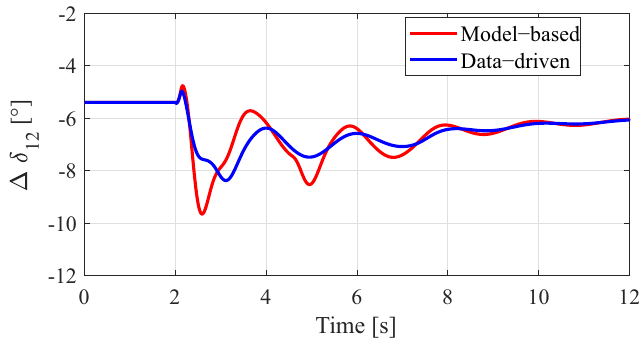
Figure 14. Rotor angles during transient fault and topology